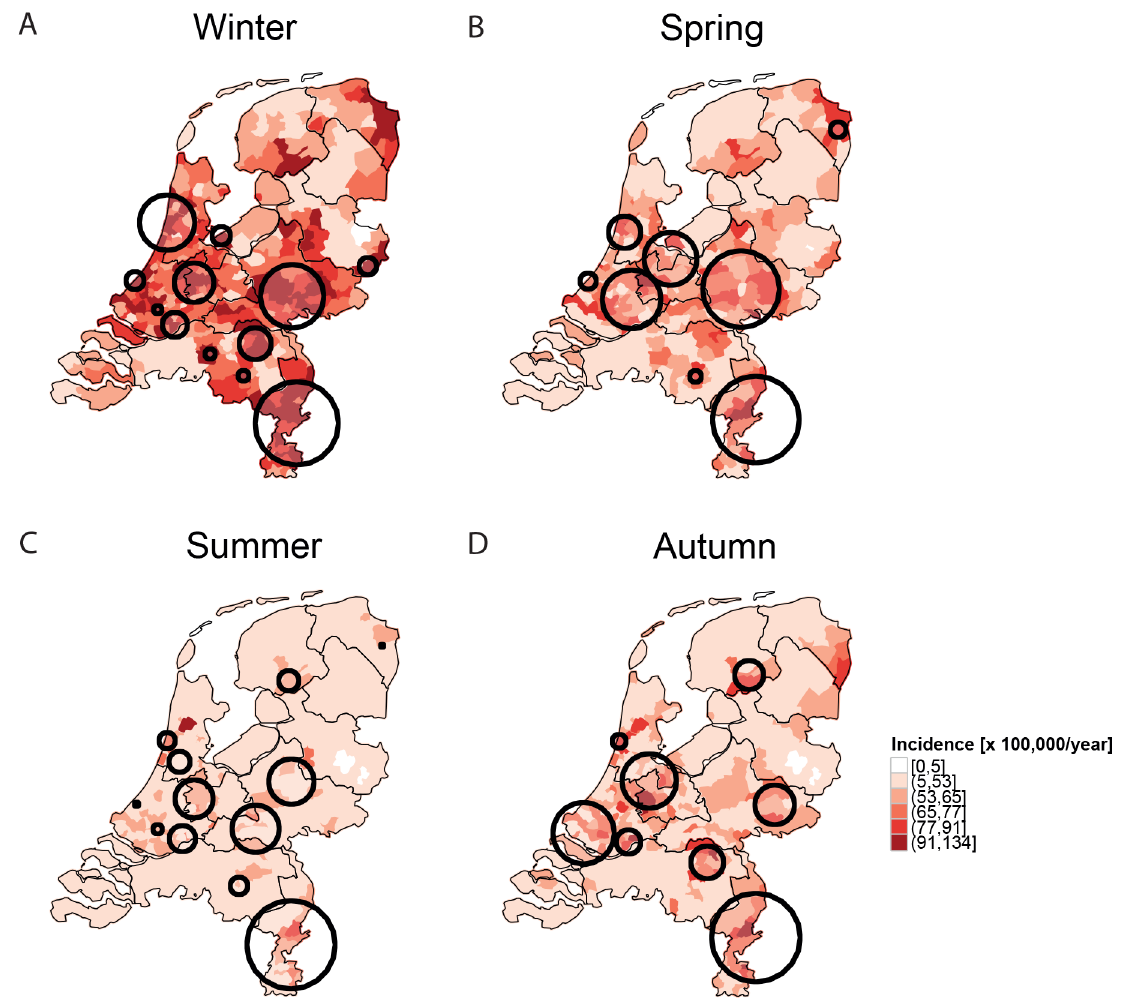
Fig 4. Maps of seasonal age-adjusted incidence of unspecified pneumonia casesat municipality level. Black circles represent significantclusters (p < 0.05)identifiedwhilst imposinga 10% upper limit. The clusters are calculatedby taking all the seasonalcases of the three years and the incidenceis calculatedby averaging over three years. The clusters in SaTScan have been adjusted by taking age class as covariatein the analysis.